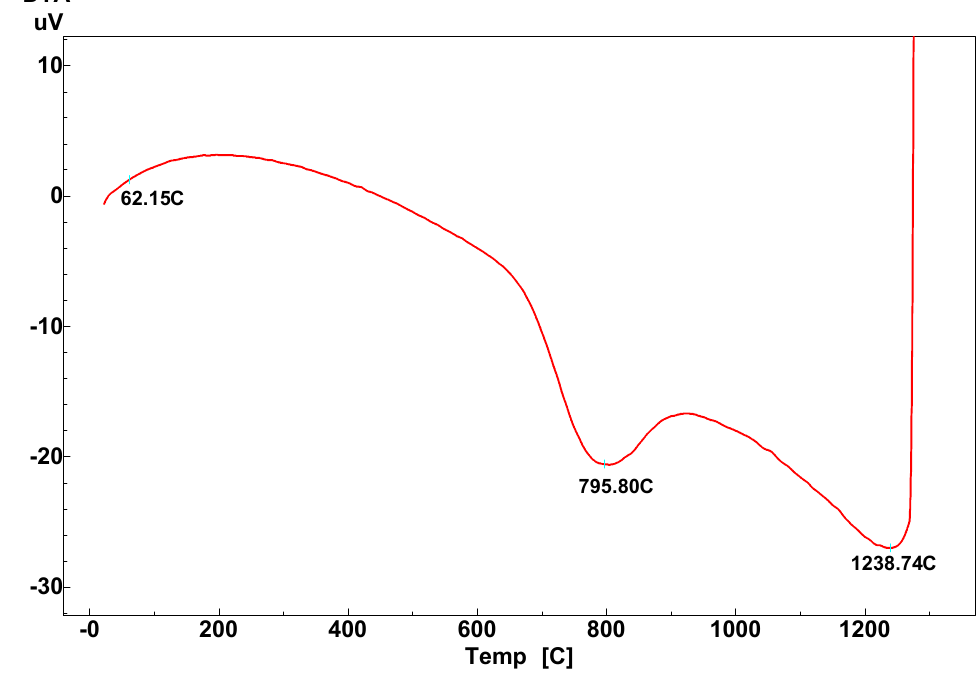
Figure 1. Differential scanning calorimetric analysis for the raw mix. Table 1. Chemical compositions of raw materials used, and the designed mineralogical composition of CSA. Raw Materials Clinker Chemical